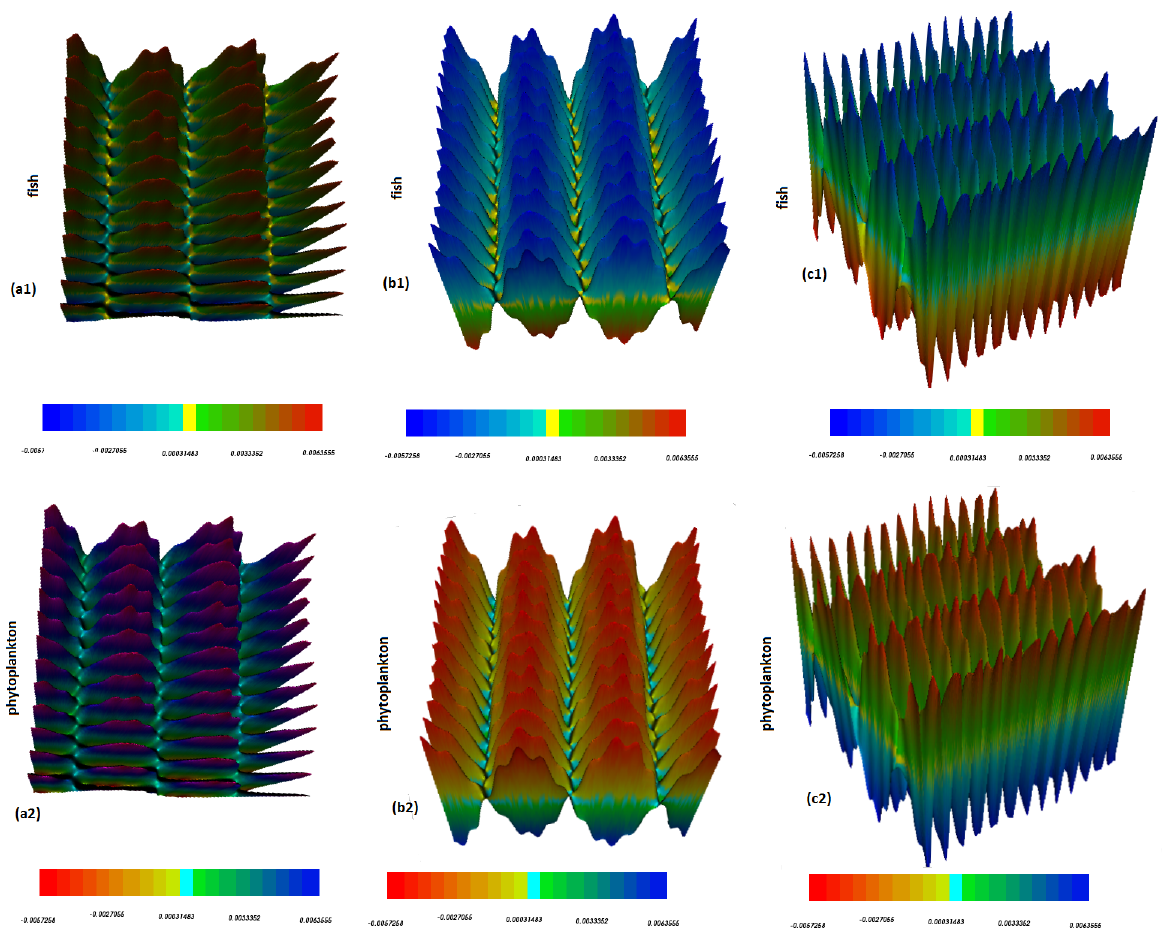
Figure 3. Dynamic behavior of two dimensional space: fish [first line] and phytoplankton [second line] population density of the model system (4). The diffusion coefficient values are δ 0 = 0.3, δ 3 = 0.4. Spatial distribution are obtained at different time levels: for plot t = 1000 ( a 1; a 2 ) ; t = 1800 ( b 1; b 2 ) ; t = 2800 ( c 1; c 2 )